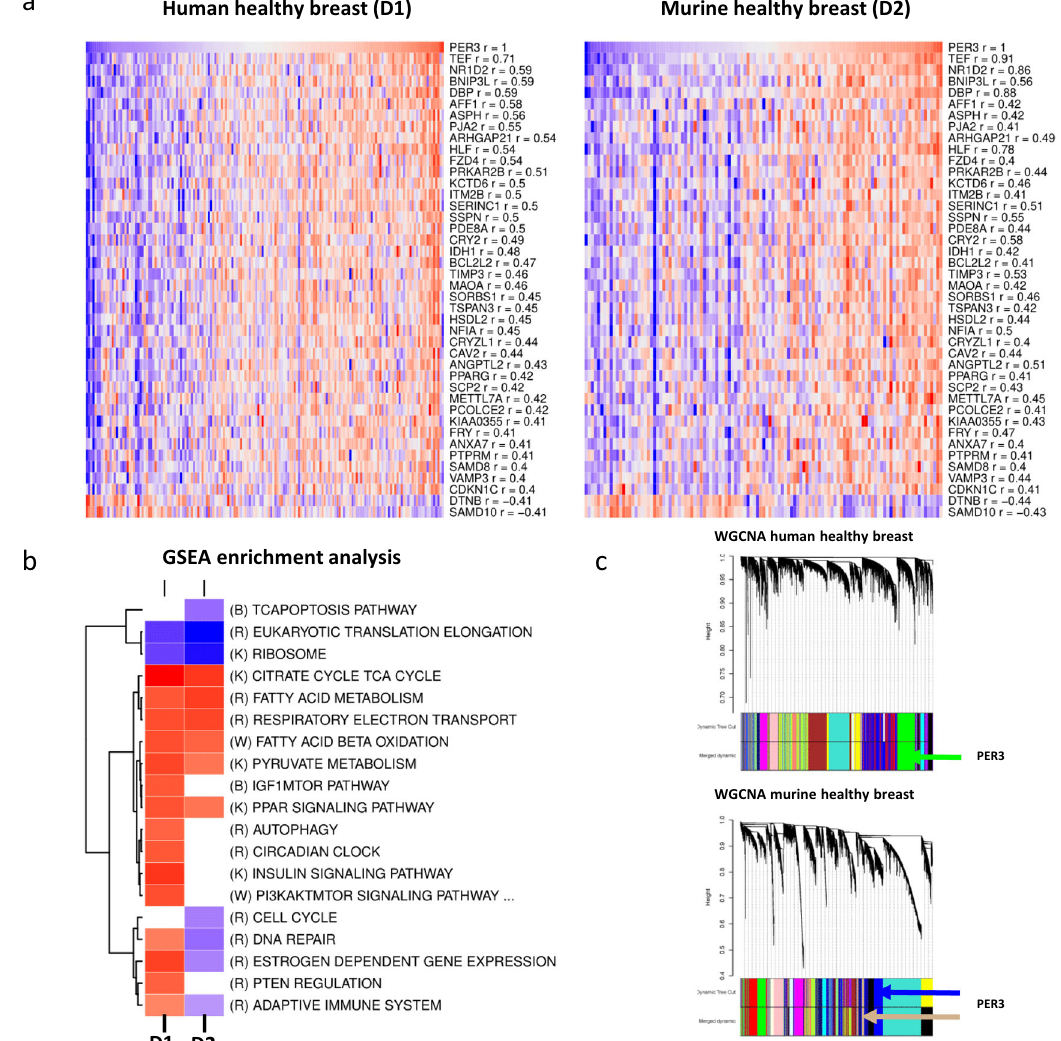
Fig. 3 PER3 co-expression analyses in healthy human and murine mammary samples. a Genes showing absolute correlation values >0.4 in both human(D1) and murine (D2)healthy breast samples datasets. b Heatmap representing the GSEA enrichment analysis results in genes positively and negatively correlated with PER3 in both human (D1) and murine (D2) healthy breast samples datasets. c Modules of co-expressed genes identi fi ed in D1 and D2 healthy breast cancer datasets by